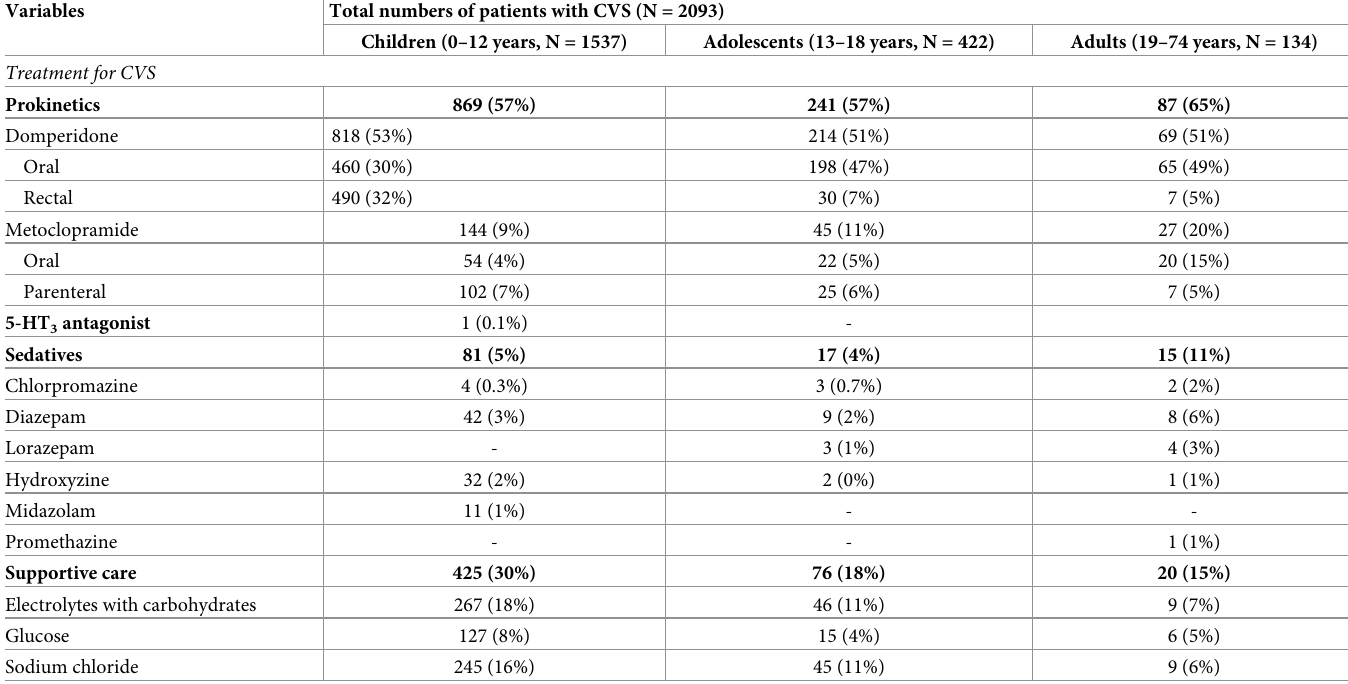
Table 4. Coadministration of identified CVS